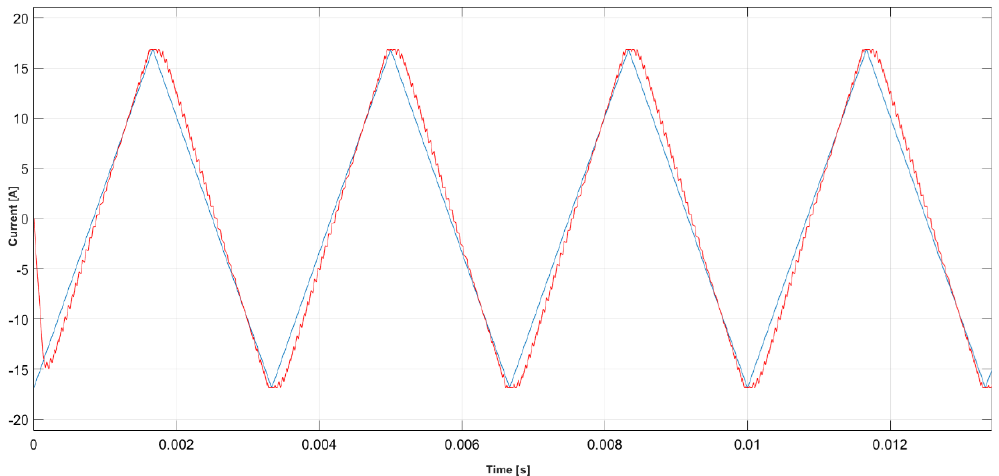
Figure 10. Reference (blue) and output (red) current waveforms for the current modulator based on the H-bridge.